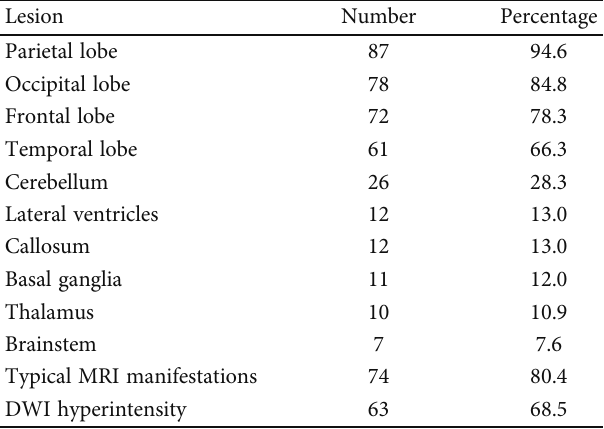
Table 4: The lesion shown on MRI ( n ,